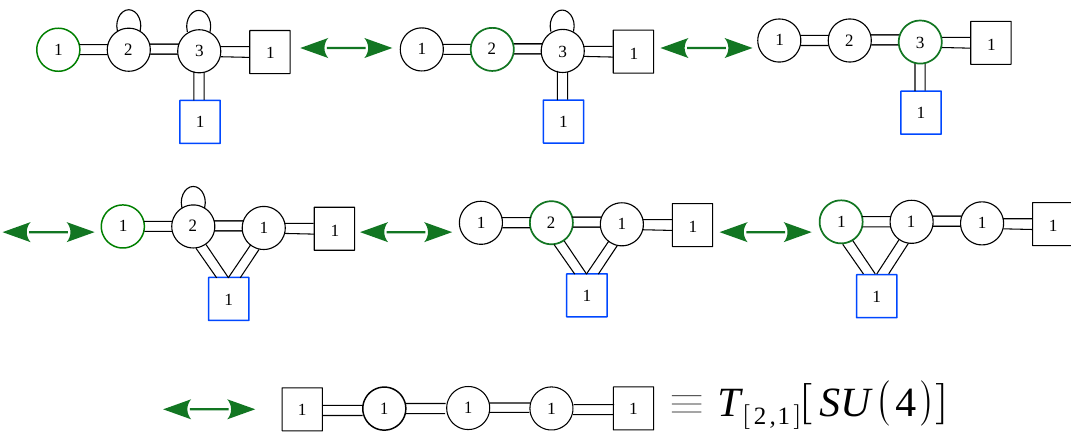
Figure 9 . Quiver representation of the iterative application of Aharony duality in the case N = 4. We highlighted in green the gauge node to which we apply the duality at each step. We only sketch the main steps and neglect gauge singlets; taking into account the S the beginning, all the remaining ones are only those corresponding to adjoint chirals for U(1) gauge